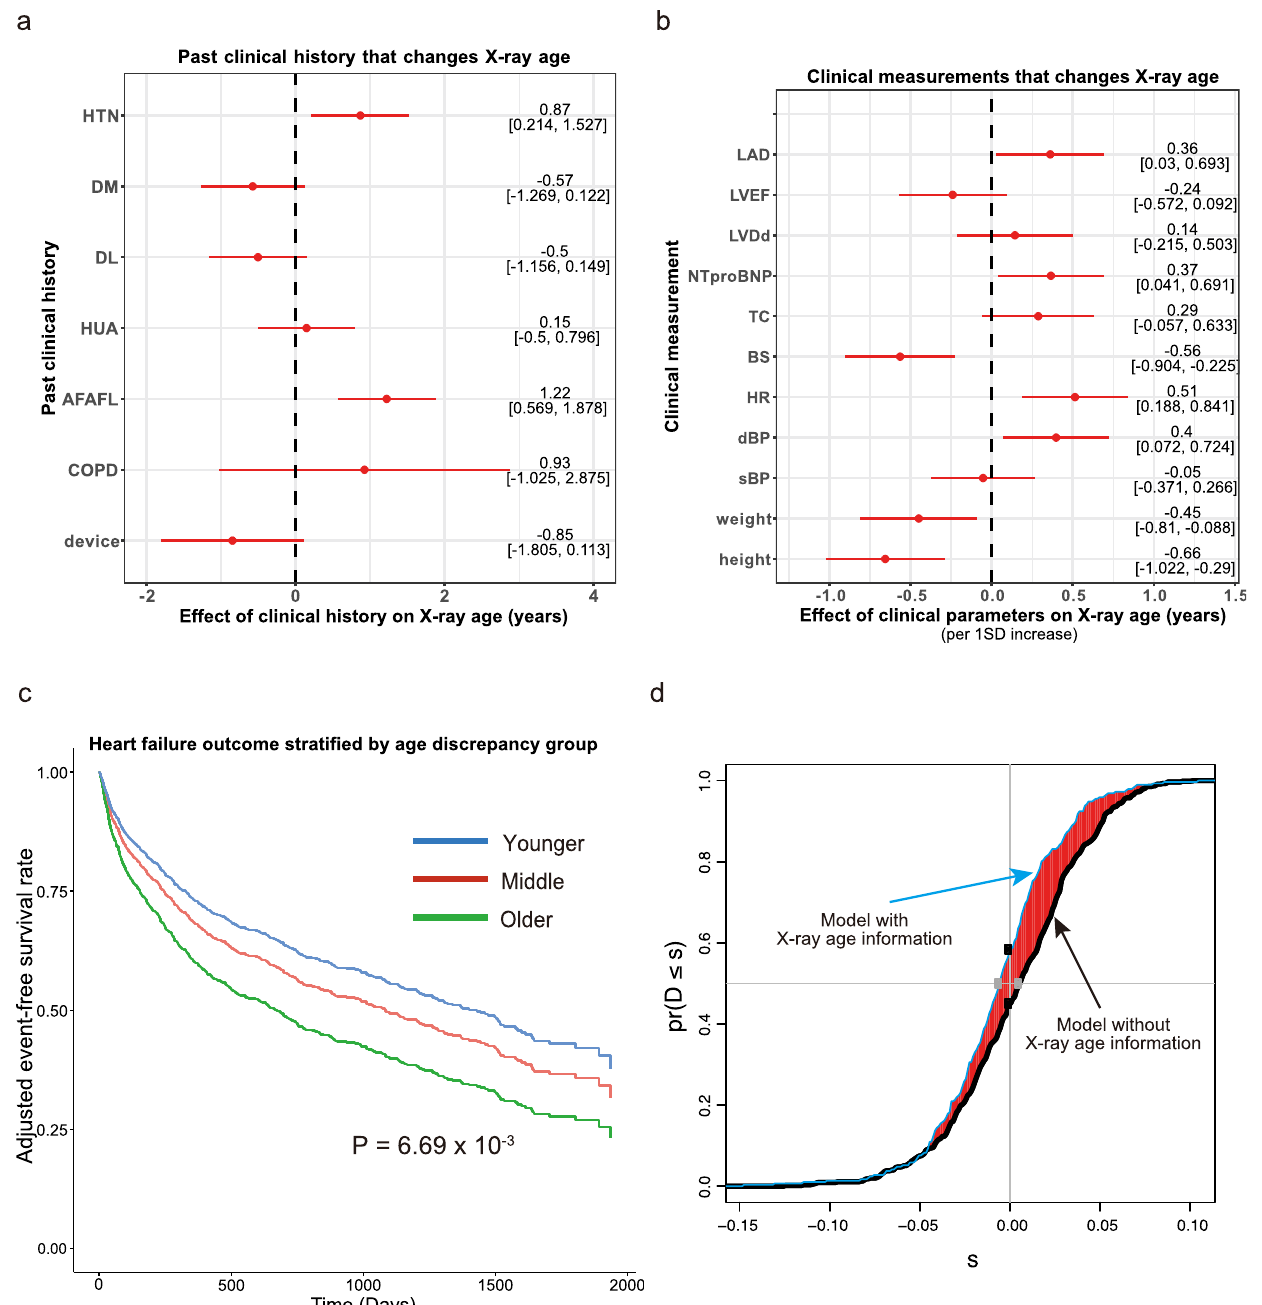
Fig. 5 Relationship between X-ray age and clinical characteristics and outcome in heart failure patients. n = 1562 study participants. Past clinical history ( a ) and continuous clinical measurements ( b ) affected X-ray age. The effect of speci fi c clinical history or clinical measurements on the predicted age is shown on the x-axis with a 95% con fi dence interval. For example, the X-ray age of patients with atrial fi brillation or atrial fl utter is likely to be estimated 1.22 years older than their chronological age. HTN hypertension, DM diabetes mellitus, DL dyslipidemia, HUA hyperuricemia, AFAFL atrial fi brillation or atrial fl utter, COPD chronic obstructive pulmonary disease, device cardiac pacemaker, implantable cardioverter de fi brillator, or cardiac resynchronization therapy devices, LAD left atrial diameter, LVEF left ventricular ejection fraction, LVDd left ventricular end-diastolic diameter, TC total cholesterol, BS blood sugar (glucose), HR heart rate, dBP diastolic blood pressure, sBP systolic blood pressure. c Adjusted event-free survival curve for heart failure patients strati fi ed by the age discrepancy between the chronological age and X-ray age. An event was de fi ned as the composite endpoint of heart failure re- hospitalization, heart transplantation and all-cause mortality. The top 20% of patients, middle 60%, and bottom 20% were grouped as older, middle, and younger, respectively. d Additional value of age discrepancy as assessed by the paired difference of risk scores derived from the Cox proportional hazard model. The fi gure shows the empirical distribution function of the change in estimated risk score for heart failure patients in the model of conventional risk factors (age, sex, body mass index, LVEF, NT-proBNP, hemoglobin, and estimated glomerular fi ltration rate) without age discrepancy (thick solid line) and the model with age discrepancy (thin blue solid line). The difference between the areas under the two curves is IDI and the distances between two black dots and between two gray dots are cNRI and median improvement,